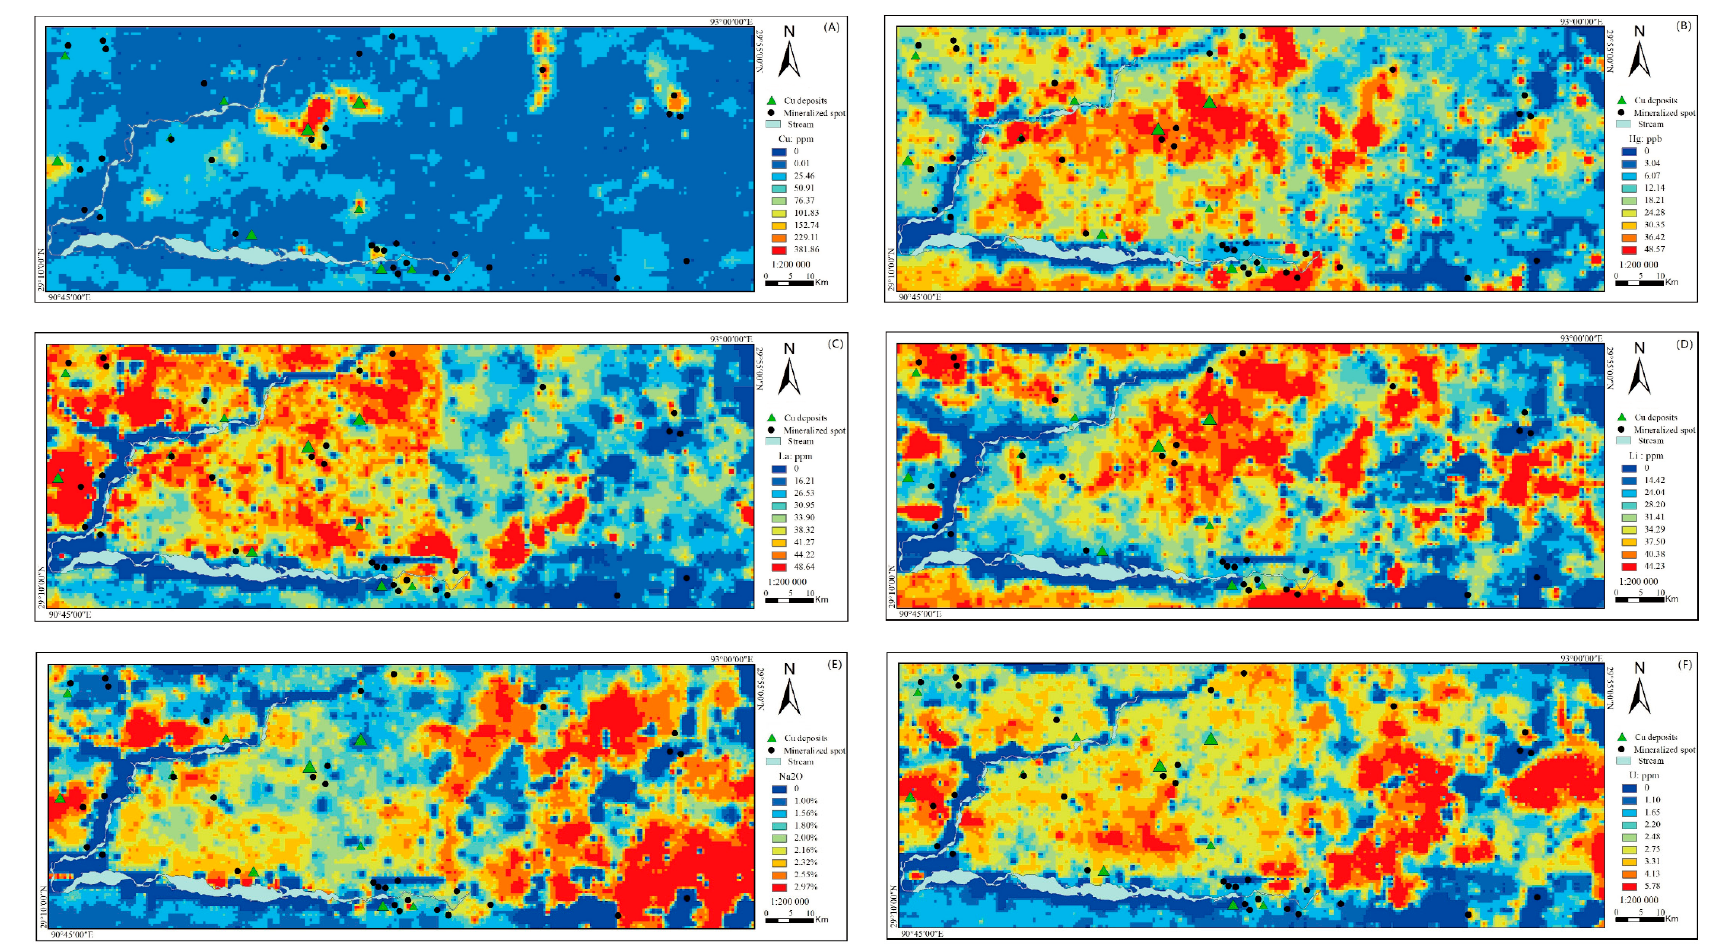
Figure 8. The distribution of elements Cu ( A ), Hg ( B ), La ( C ), Li ( D ), Na 2 O ( E ), and U ( F ).